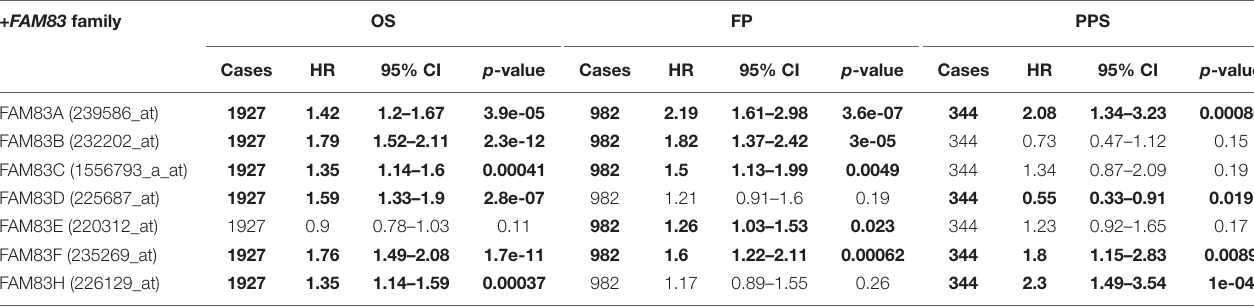
Bold values mean p <